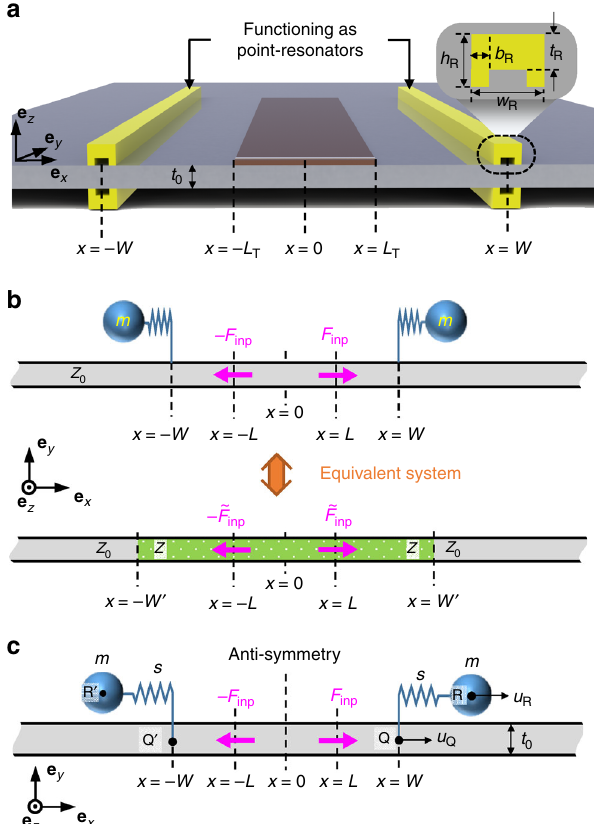
Fig. 2 The sketch of proposed paired resonator system. a Sketch of a thin plate with two resonators installed at x = ± W . Each resonator at x = W or x = − W consists of two symmetrically con fi gured C-shaped beams to ensure the generation of pure thickness-symmetric longitudinal waves without generating thickness-antisymmetric bending waves. (The dimension of the C-channel box beam aluminum resonators are t R = 3 mm, w R = 6 mm, h R = 4.5 mm, b R = 1.5 mm, and test plate thickness t 0 = 2 mm.) b One- dimensional bar models describing the longitudinal motion in the plate shown in a . The model in the top illustration depicts a bar equipped with two point resonators, while the model in the bottom illustration is an equivalent bar model with a modi fi ed effective impedance to account for the effects of resonators on wave motion. The actuation by the PZT patch is modeled with two concentrated pin forces. c Analysis of bar model in which the displacements in various locations are speci fi